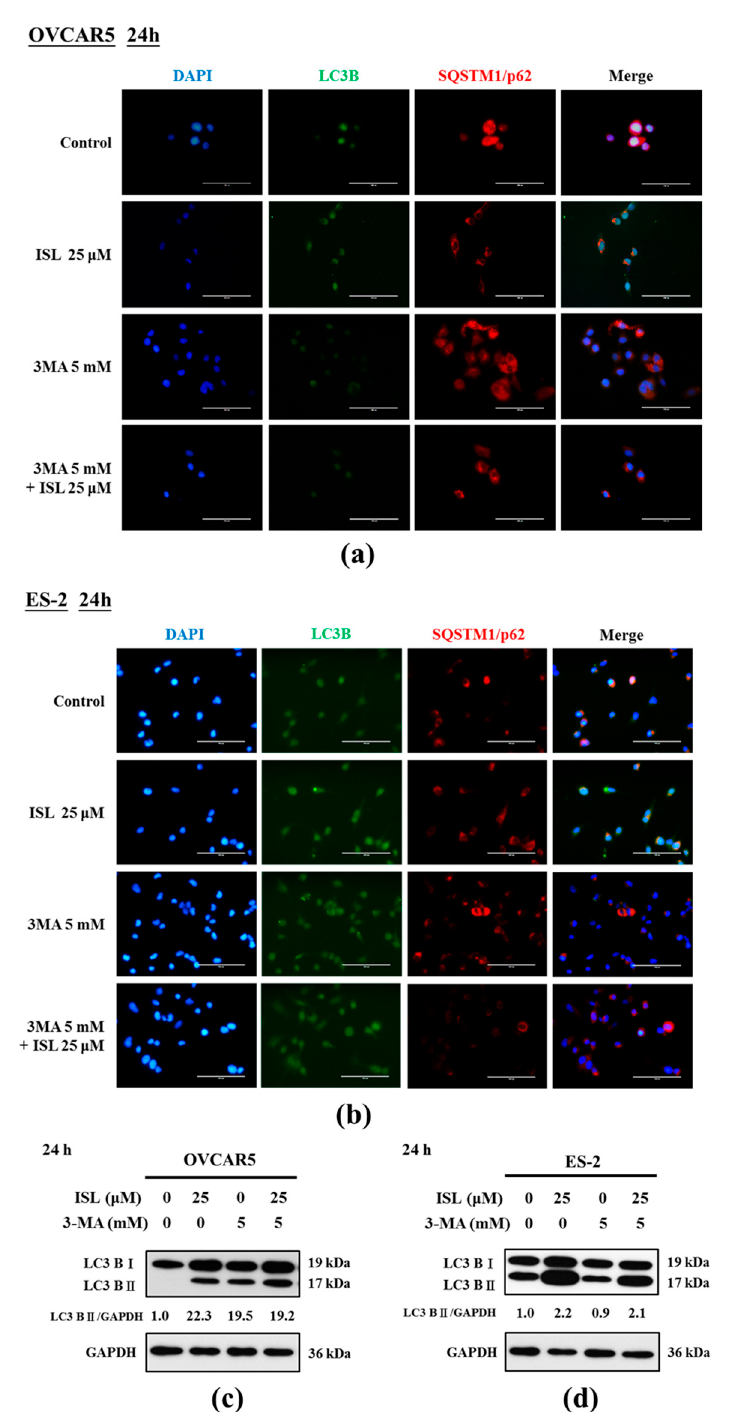
Figure 4. ISL triggered autophagy in ovarian cancer cells. OVCAR5 and ES-2 cells were treated with ISL 25 μ M for 24 h with or without autophagy inhibitor (3-MA) pretreatment (5 mM, 4 h), and observed the co-localization of LC3 puncta (green) and p62/SQSTM1 puncta (red, demarcation for the lysosome) in cells, DAPI (4 ′ ,6-Diamidino-2-Phenylindole) was used for nucleus staining. Bars equal to 100 μ m ( a , b ). OVCAR5 and ES-2 cell lysates were separated by SDS-PAGE and analyzed on western blot with autophagosome formation marker LC3B-I and LC3B-II. GAPDH was used as a loading control. The values of the band intensity are expressed as the ratio LC3B-II:GAPDH relative to control ( c , d ).